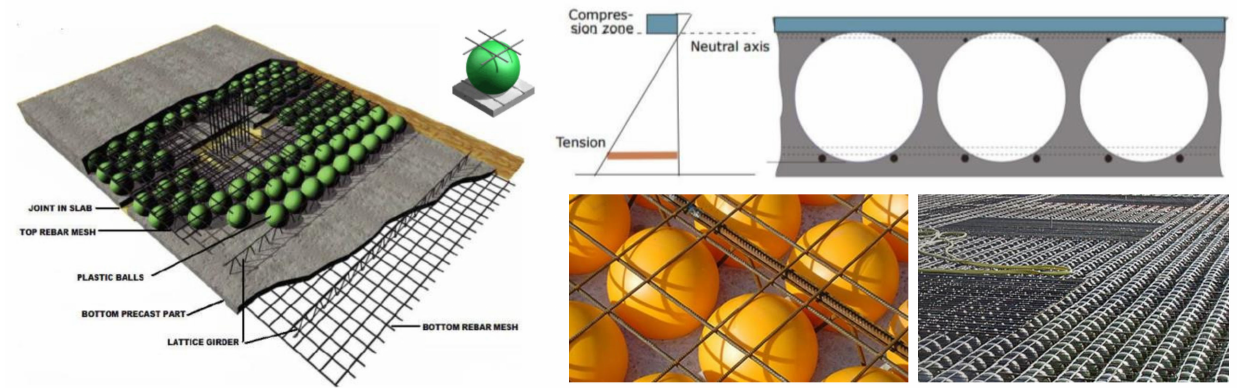
Figure 1. The concept of voided slab system and their application (BubbleDeck)